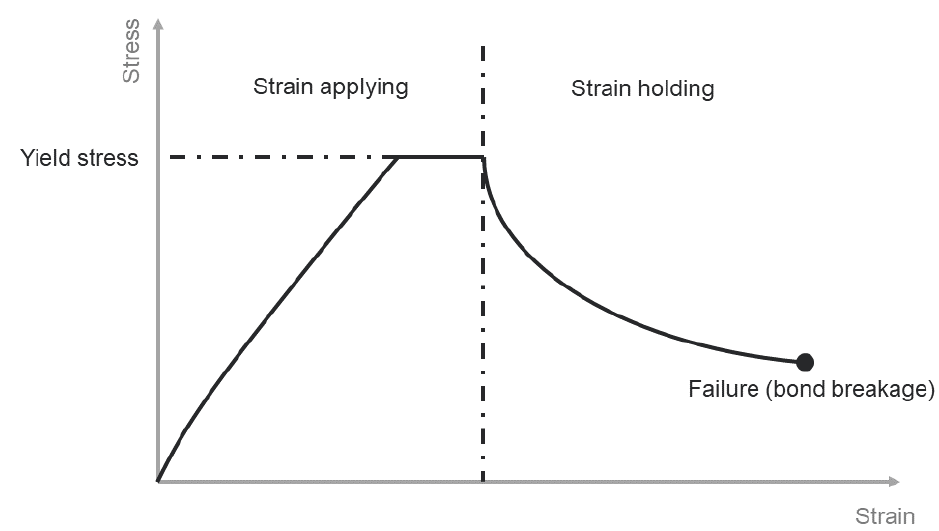
Figure 7. Schematic stress-strain diagram for solid bond under load in the normal direction.